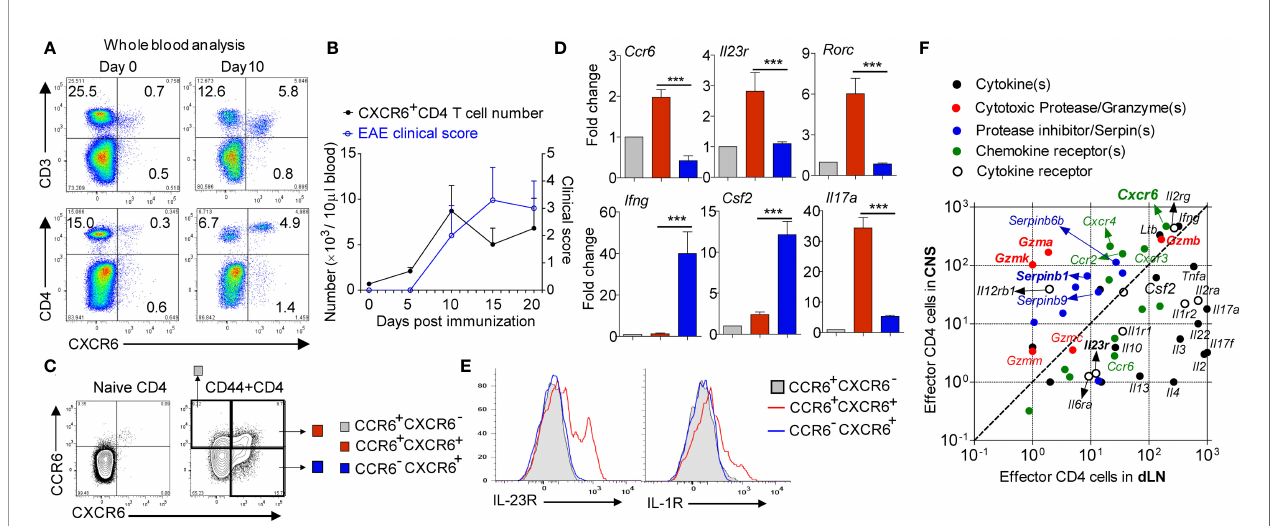
FIGURE 1 | CXCR6+CD4 cells in EAE. (A) Representative FACS data gating on blood leukocyte. (B) Cell number. N = 4 in each time points. (C) Gating strategy for FACS sorting or analysis of CD4 cells in dLN at EAE onset. (D) Relative gene expression of CCR6+CXCR6 − , CCR6+CXCR6+and CCR6 − CXCR6+ effector CD4 cells; CCR6+CXCR6 − was used as control. Data are mean ± SEM of 3 independent experiments. ***p <0.001. (E) Representative FACS data showing IL23R and IL1R expression on CD4 cells in dLN at EAE onset. (F) Effector CD4 cells were isolated from both dLN and spinal cord at EAE onset, and subjected to bulk RNAseq. Data are presented by